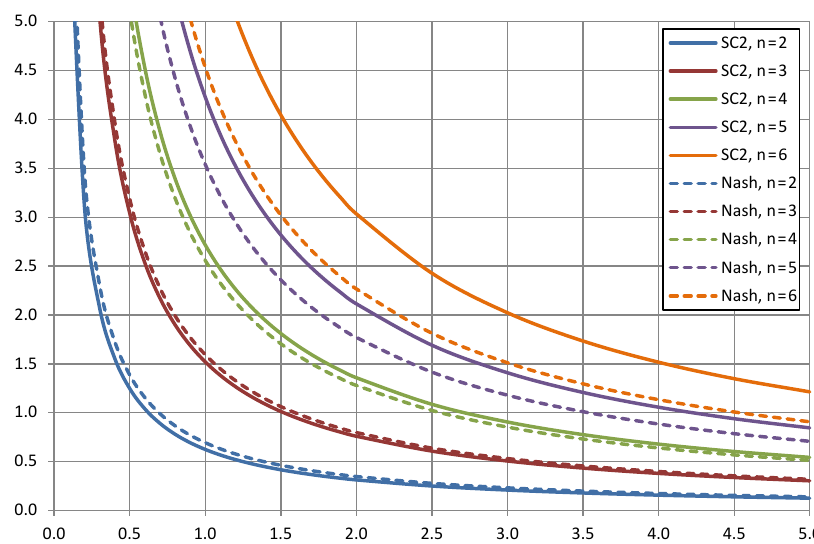
Figure 8. IUH lag time in SC2 and Nash models versus storage coefficient k